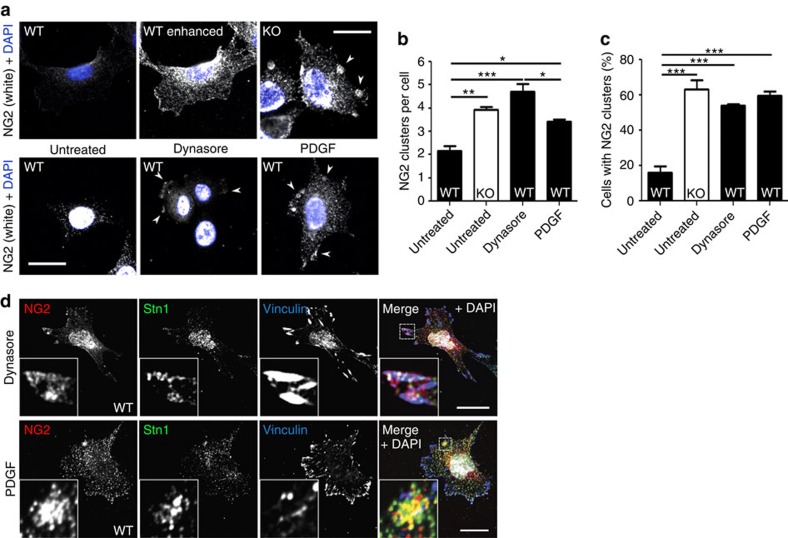
Increased NG2 clustering in Stonin1−/− MEFs.(a–c) Stonin1−/− MEFs display NG2 clusters constitutively, WT MEFs only upon stimulation or inhibition of endocytosis. (a) Epifluorescent images of fixed MEFs immunolabelled with NG2-specific antibodies, which were untreated or incubated with 100 μM dynasore or 50 ng ml−1 PDGF for 30 min. Top left and right: images of WT and Stonin1−/− KO MEFs taken with same exposure; remaining WT images have enhanced contrast to visualize low levels of NG2. Arrowheads indicate clusters. Scale bar, 25 μm. Quantification of NG2 clusters per cell (b) and percentage of cells containing NG2 clusters (c) (data are depicted as mean±s.e.m., one-way analysis of variance followed by Tukey's post-test, N=3, n>182, ***P<0.001, **P<0.01, *P<0.05). (d) Stonin1 is present in NG2 clusters. Confocal images of WT MEFs treated with PDGF or dynasore as above and immunolabelled with antibodies against the indicated proteins. Scale bar, 25 μm. DAPI, 4,6-diamidino-2-phenylindole.